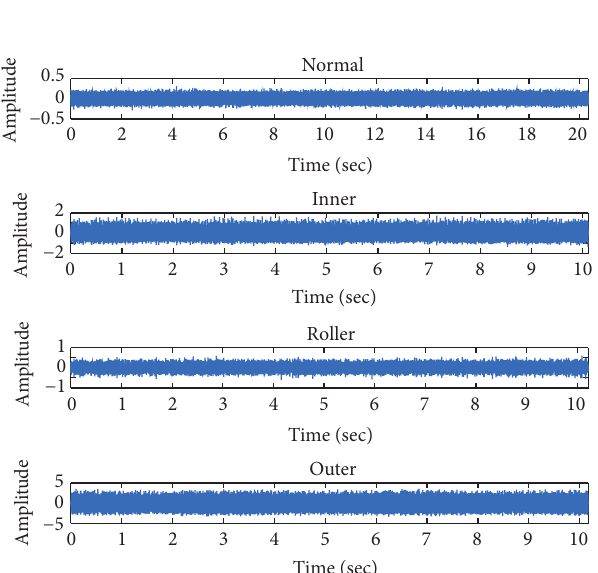
Figure1:Thetimedomainvibrationaccelerationsignalsfornormal, inner race, ball/roller, and outer race faults.